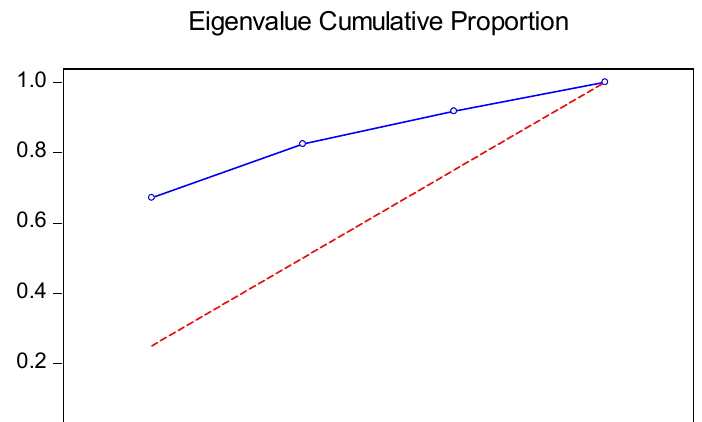
Figure 2. Scree plot and eigenvalue cumulative proportion.